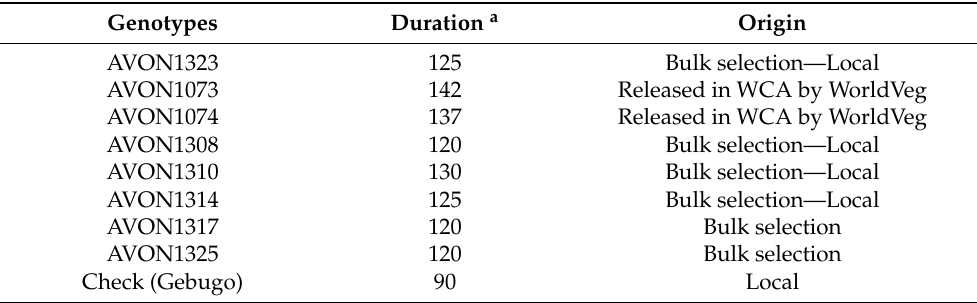
Table 1. Onion varieties evaluated in northern Ghana and southern Mali, 2018–2020. Genotypes Duration